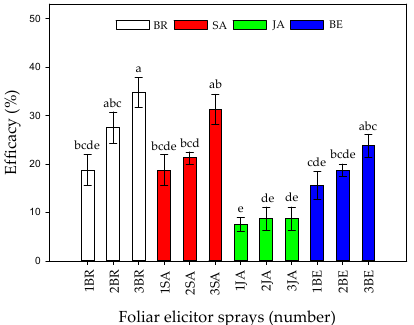
Figure 2. Effect of the interaction between synthetic elicitors (Salicylic acid (SA), jasmonic acid (JA), Brassinosteroids (BR), or botanical extracts (BE)) and the sprays number (0, 1, 2 and 3 applications) on control efficacy in Fusarium oxysporum f. sp. physali infected cape gooseberry ( Physalis peruviana L.) plants at 50 DAI. Data represent the average of ten plants ± SE per treatment ( n = 10). Bars followed by different letters indicate statistically significant differences according to the Tukey test ( p ≤ 0.05).